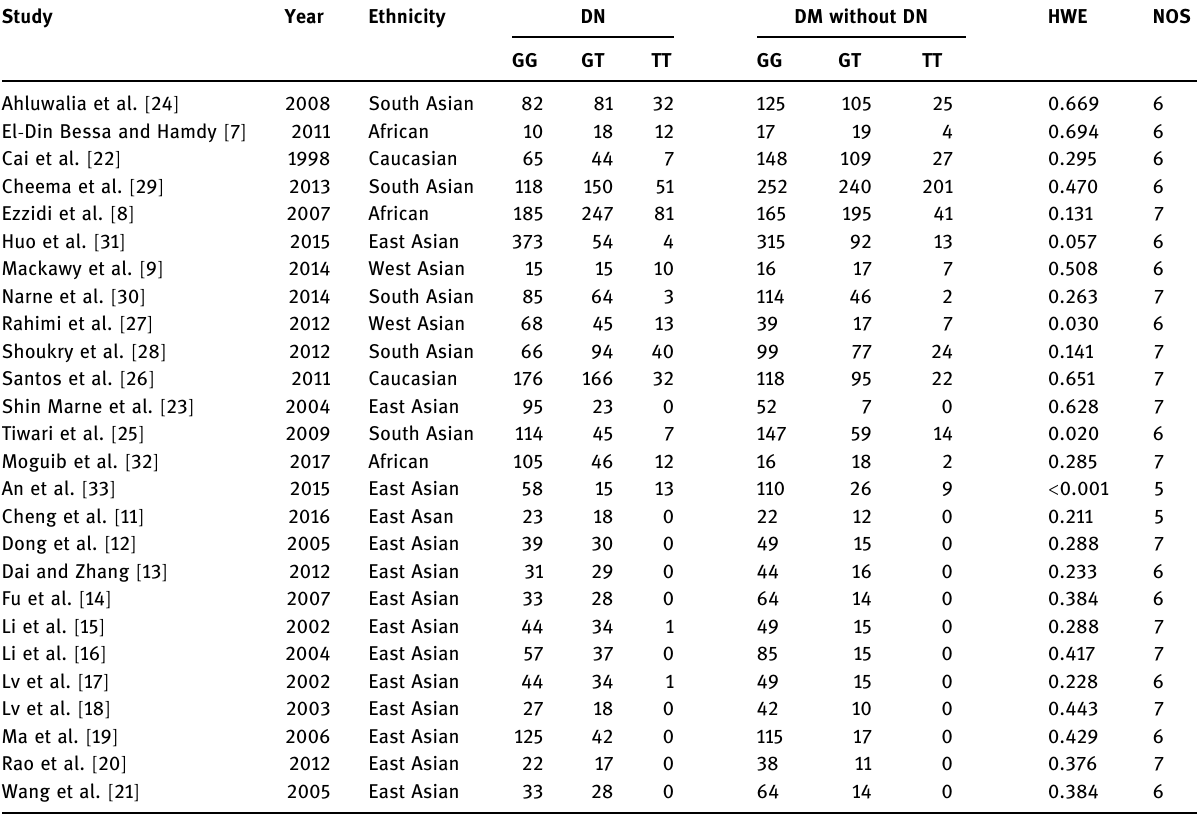
Table 1: The main features of the included studies